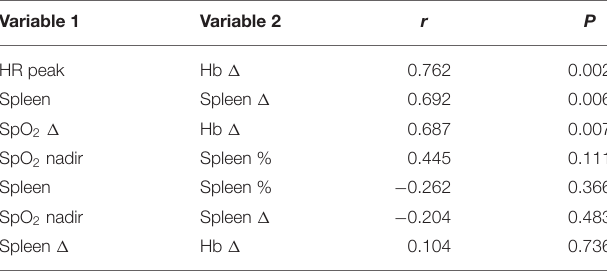
TABLE 2 | Correlation